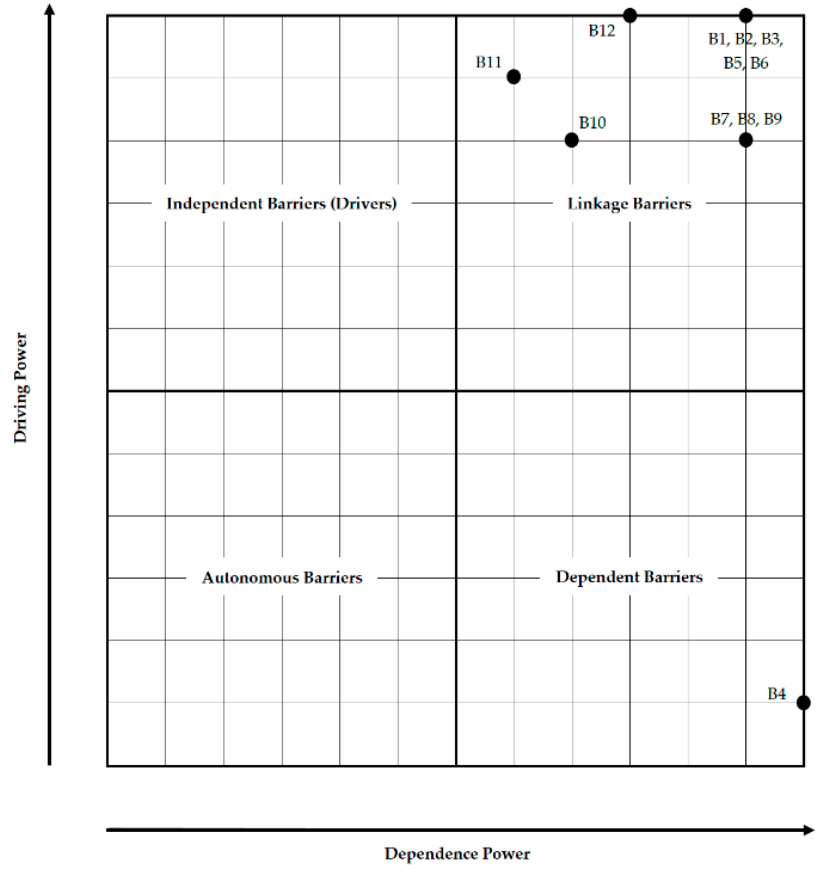
Figure 1. Categorization (clustering) of barriers to green entrepreneurship (GE).